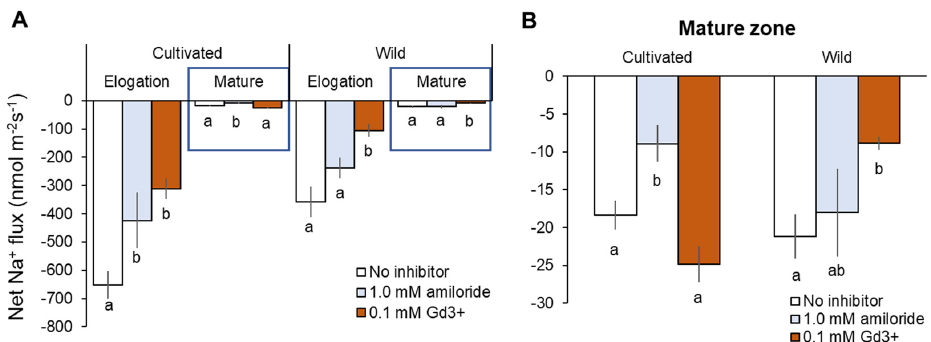
LSD tests). Mean ± SE ( n =